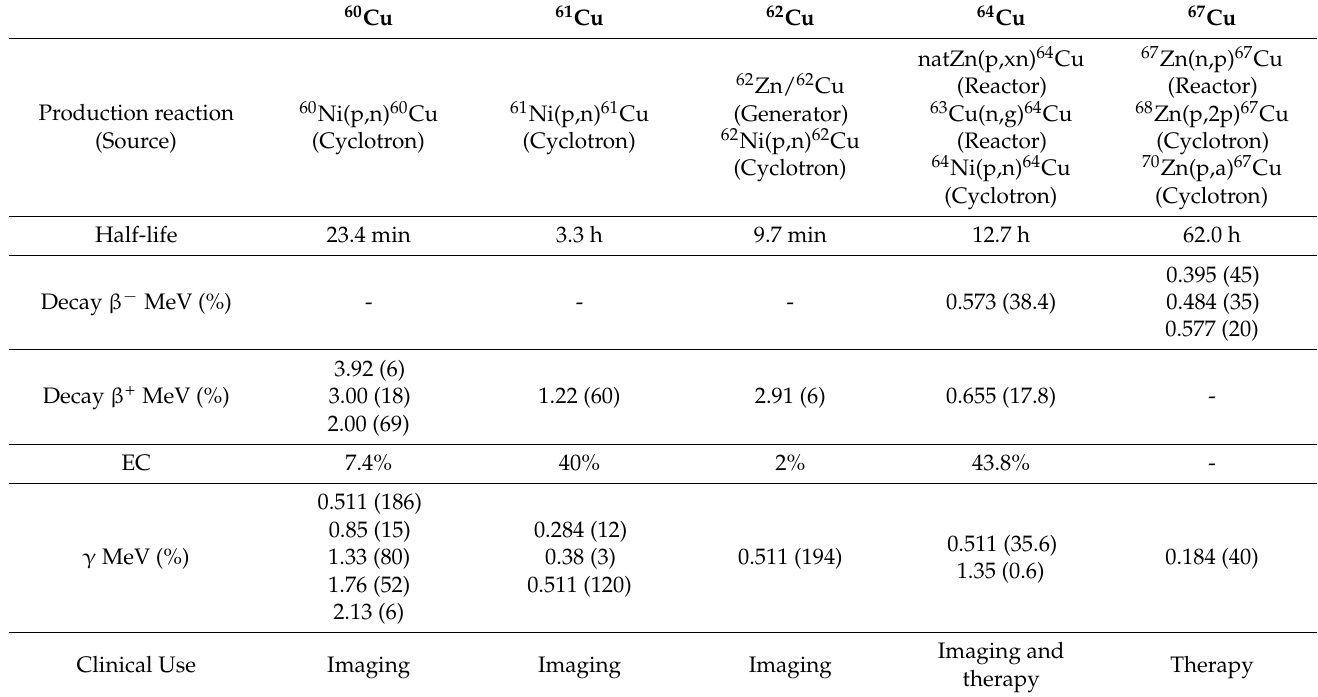
Table 1. Decay characteristics and properties of copper